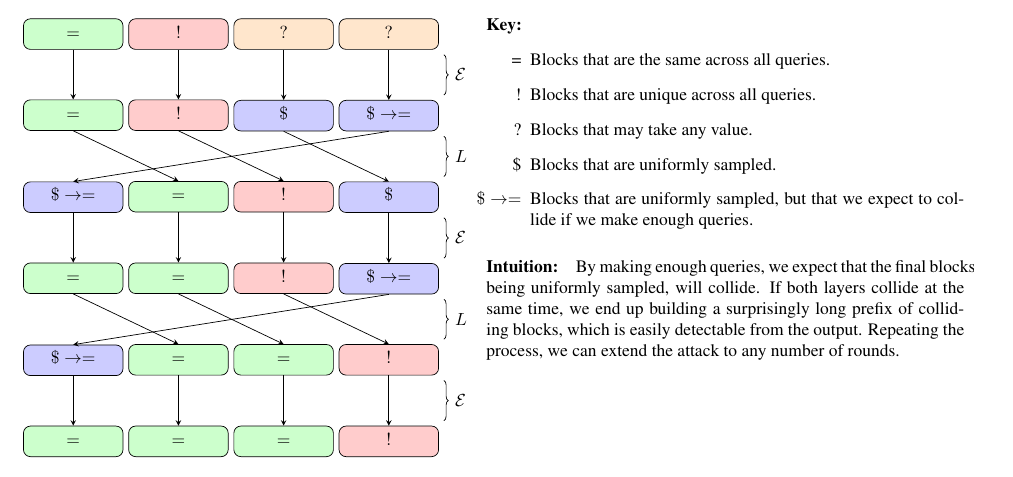
Figure 17: An attack against Π right